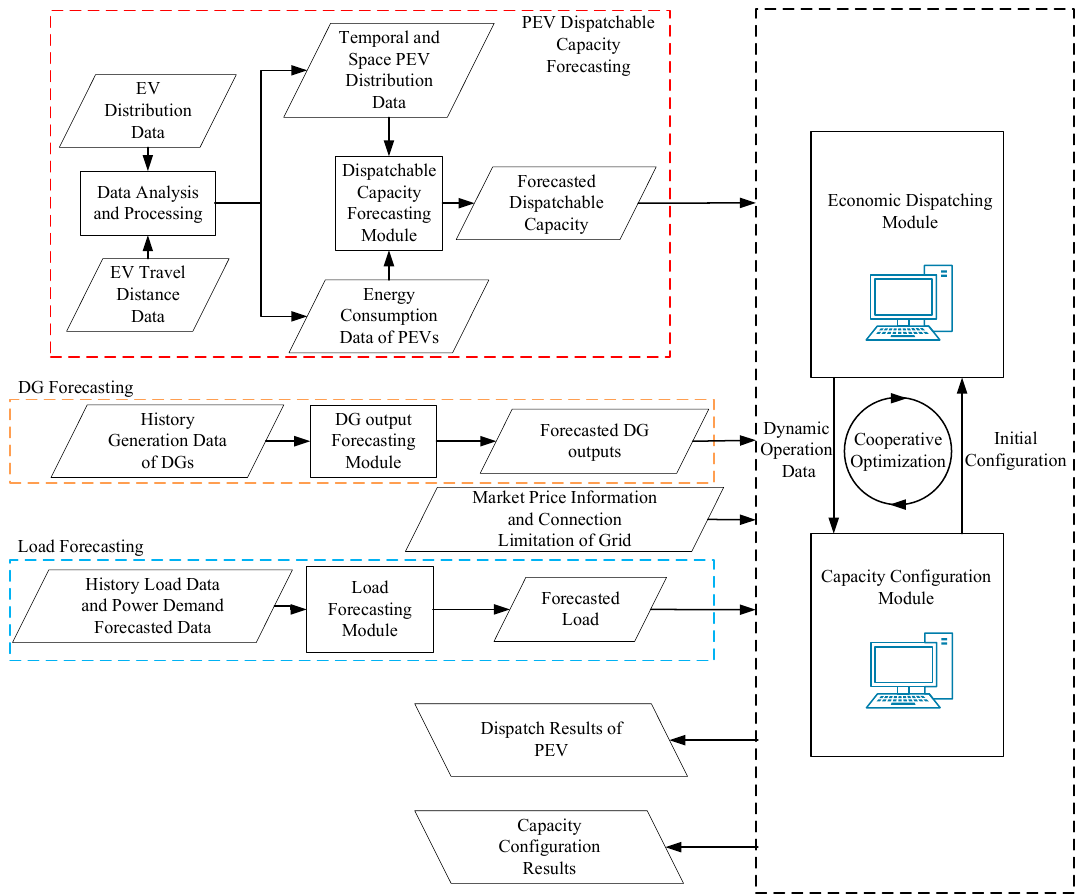
Figure 3. Mechanism of the cooperative optimization.